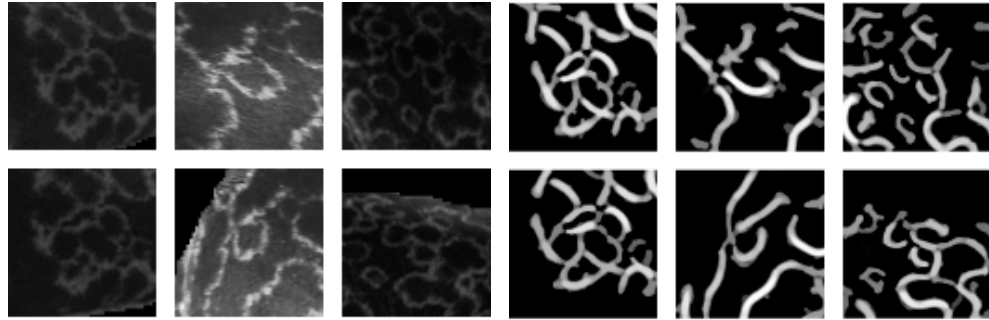
Figure 3. Examples of patches. Original patches ( left ). The corresponding pattern patches ( right ).